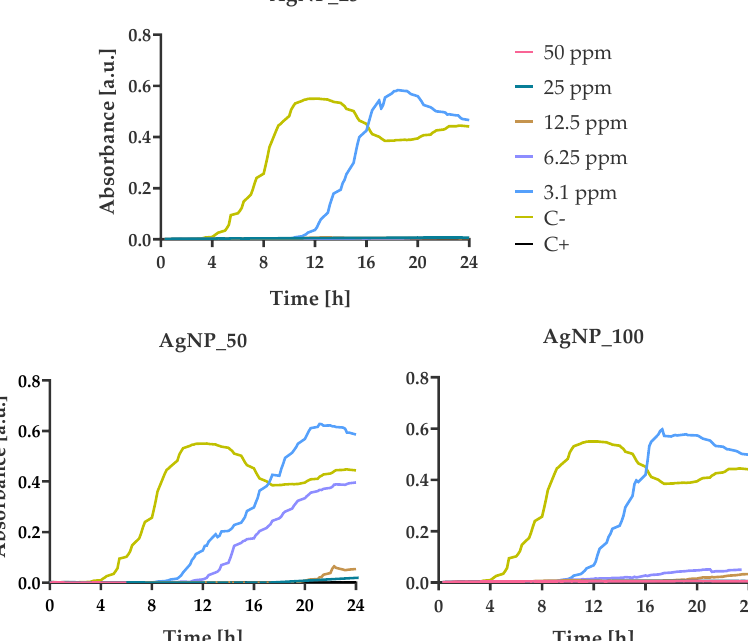
Figure 7. Growth kinetics of P. aeruginosa in the presence of different concentrations (from 3.125 to 50 ppm) of AgNPs. Optical density was measured for 24 h at 37 ◦ C using a multi-detection microplate reader at 600 nm and automatically recorded for each well every 15 min. In all experiments, the bacterial suspension in pure MH-B and in the presence of streptomycin (100 ppm) were taken as negative and positive control, respectively. The growth kinetics of S. aureus demonstrated a similar trend to E. coli for all tested AgNPs samples (Figure 8). Based on the kinetic diagrams, similarities were observed in the extended lag phases with a delay from 1 h (AgNP_25) to 8 h (AgNP_50) and 10 h (AgNP_100) and a robust bactericidal effect from 12.5 ppm (AgNP_25) to 6.25 ppm (AgNP_50) and 3.1 ppm (AgNP_100).